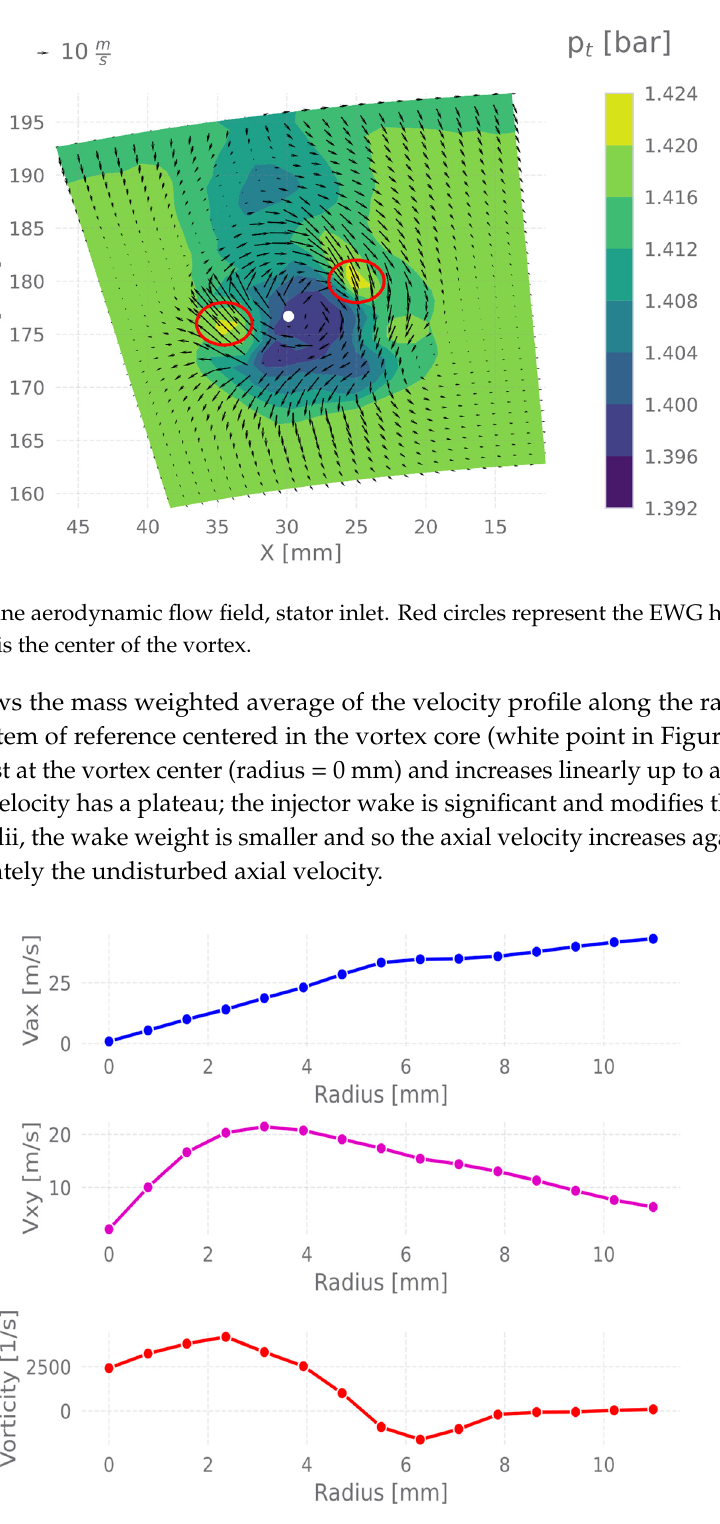
Figure 19. EWG axial (up) and tangential (intermediate) averaged velocity profile. Vorticity in the bottom frame.